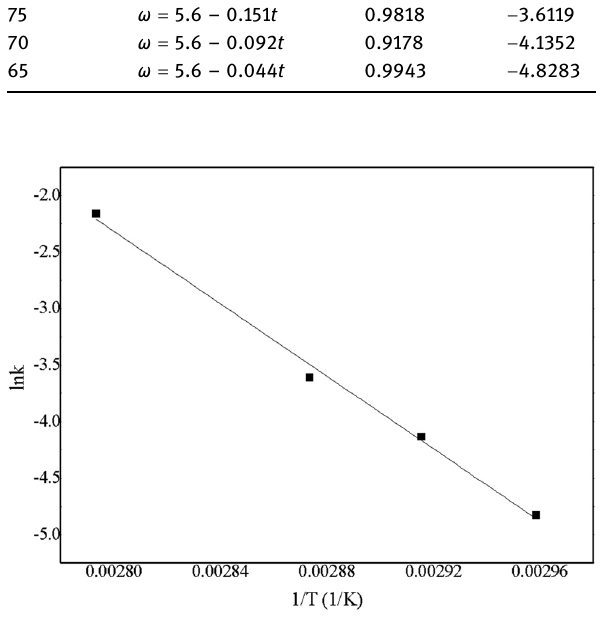
Figure 3: ln k as function of 1/ T